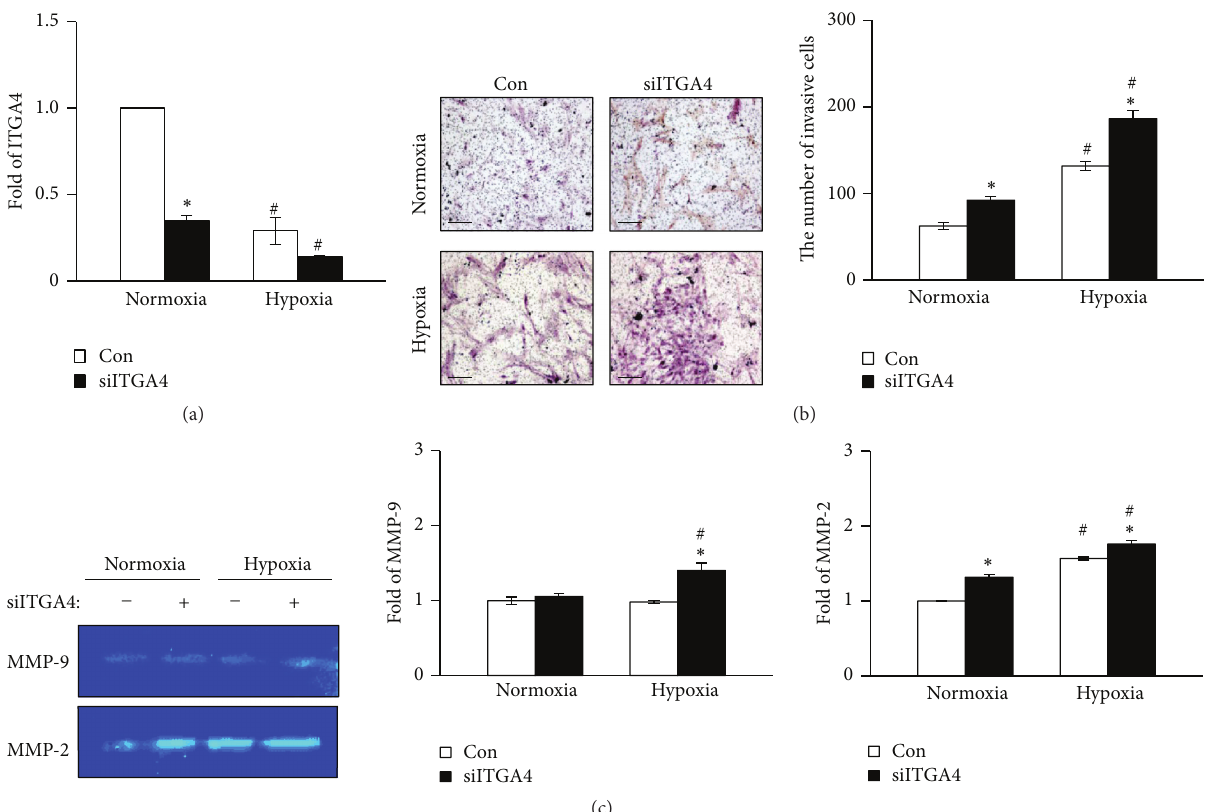
Figure 4: The effect of integrin 𝛼 4 inhibition on BM-MSC migration and activities of MMPs under hypoxia. (a) The mRNA expression of integrin 𝛼 4 in BM-MSCs was suppressed by transfection of integrin 𝛼 4 siRNA. 18S rRNA was used as the loading control. (b) BM-MSC migration was significantly increased after siITGA4 transfection. Invasiveness of BM-MSCs was assessed by invasion assay (left). BM-MSCs invaded through the inserts were counted for quantification (right). (c) Enzymatic activities of MMP-9 and MMP-2 in BM-MSCs after siITGA4 transfection were determined by zymography (left). Quantification of enzymatic activities of MMP-9 (middle) and MMP-2 (right). ∗ 𝑃 < 0.05 (compared with siITGA4 nontransfected group) and # 𝑃 < 0.05 (compared with normoxic group). MMP: matrix metalloproteinase; siITGA4: integrin 𝛼 4